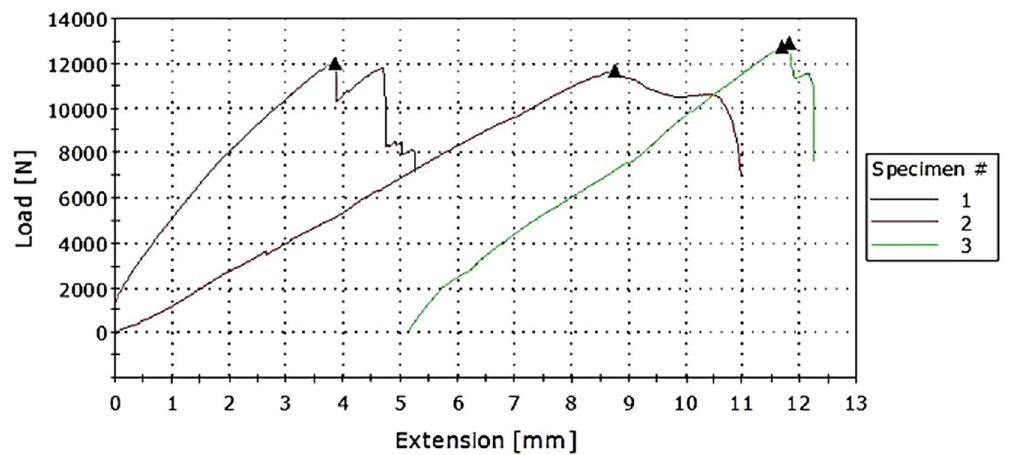
Figure 2. Tensile strength against sisal content (1) G4; S9, (2) G4; S6 (3) G4; S3.